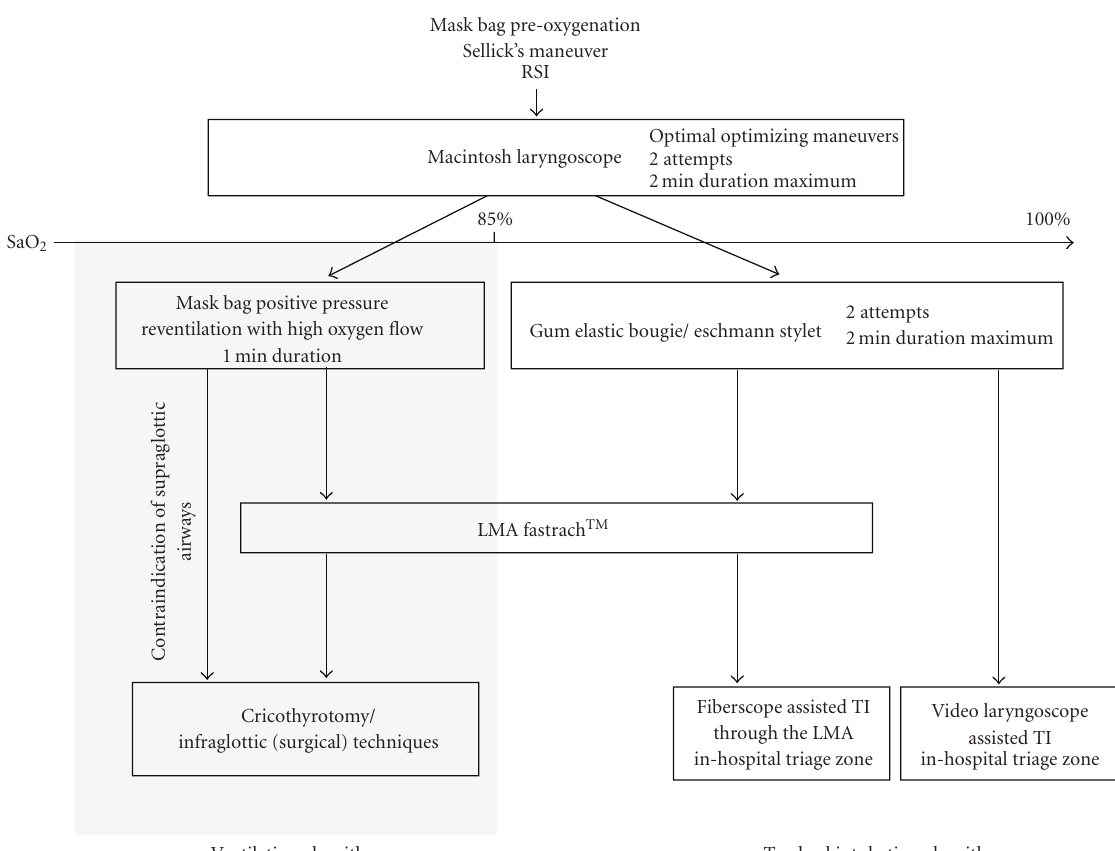
Figure 1: Di ffi cult Airway Management